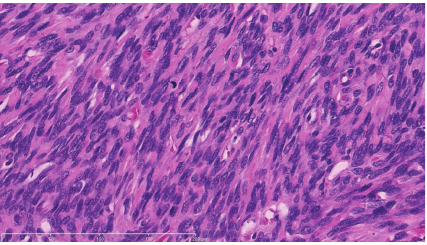
Figure 6: Spindle cells show marked nuclear atypia, overcrowding, and brisk mitotic activity. × 400